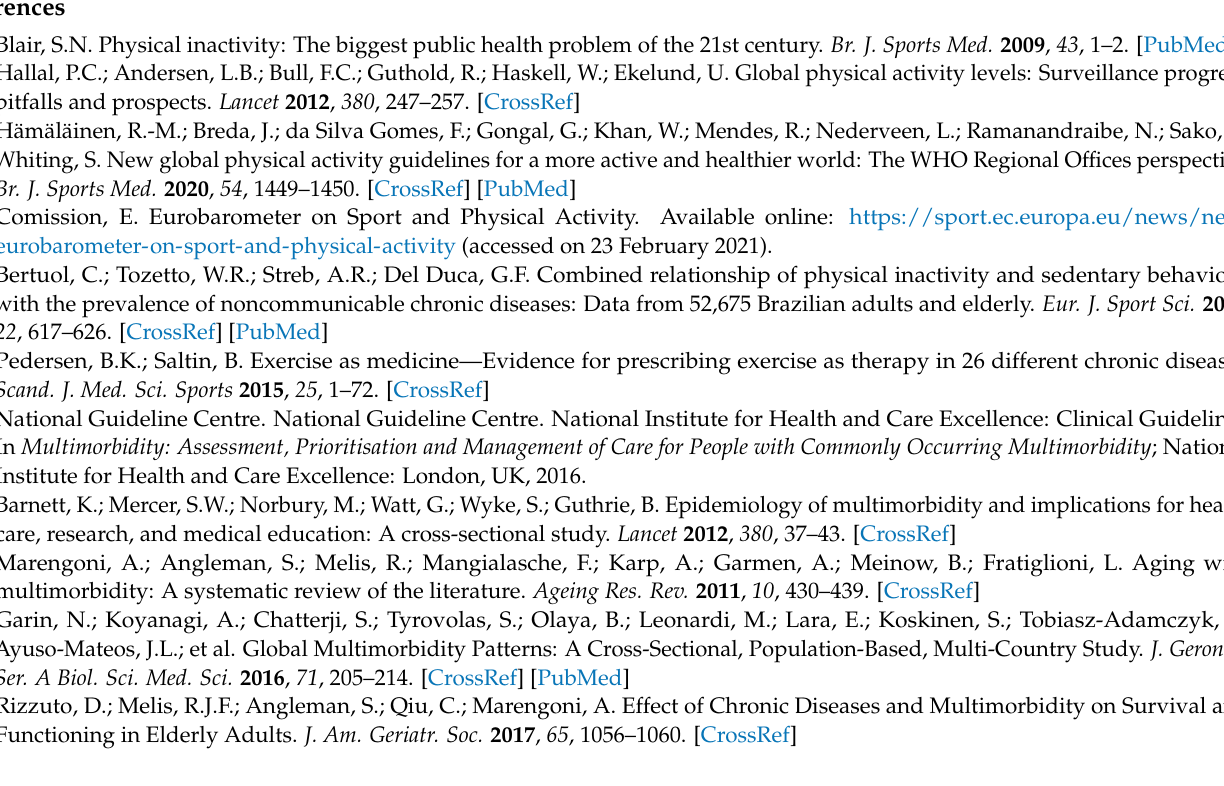
Figure A1. Changes in physical exercise participation separated for the two recruitment groups.